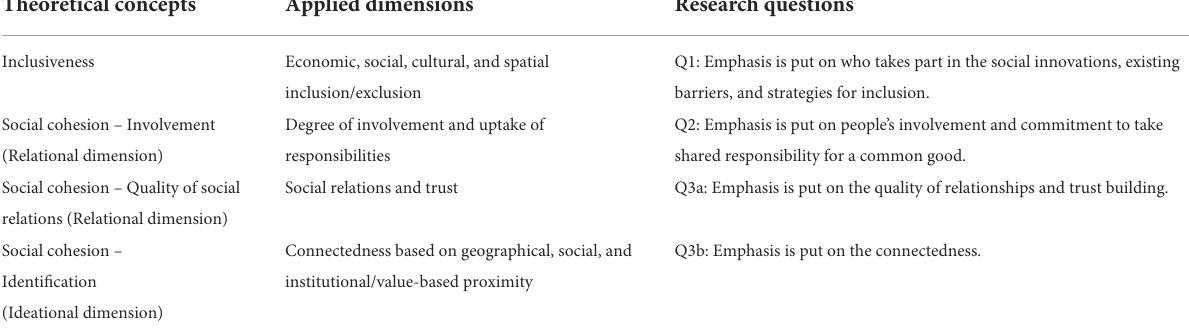
TABLE 1 Applied dimensions and research